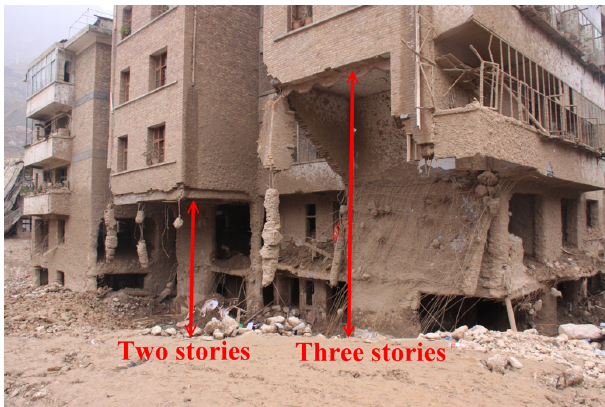
Fig. 5. Differing extent of damage to building H by longitudinally decreasing impact force.